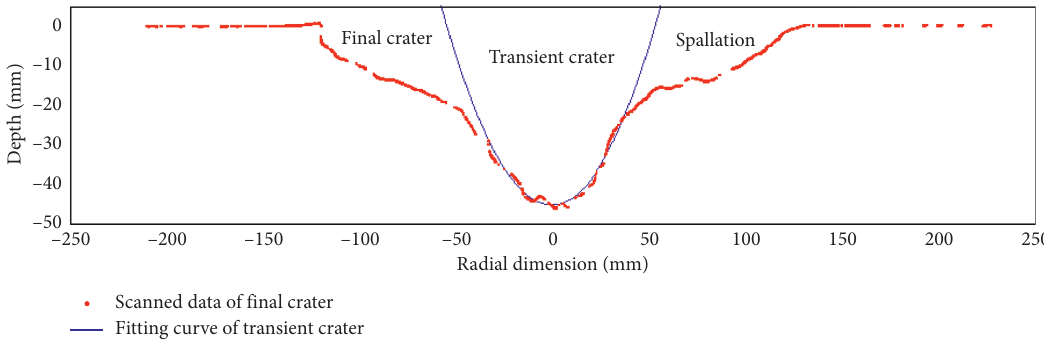
Figure 10: Parabolic fitting of transient craters. Table 2: Experimental results of the transient